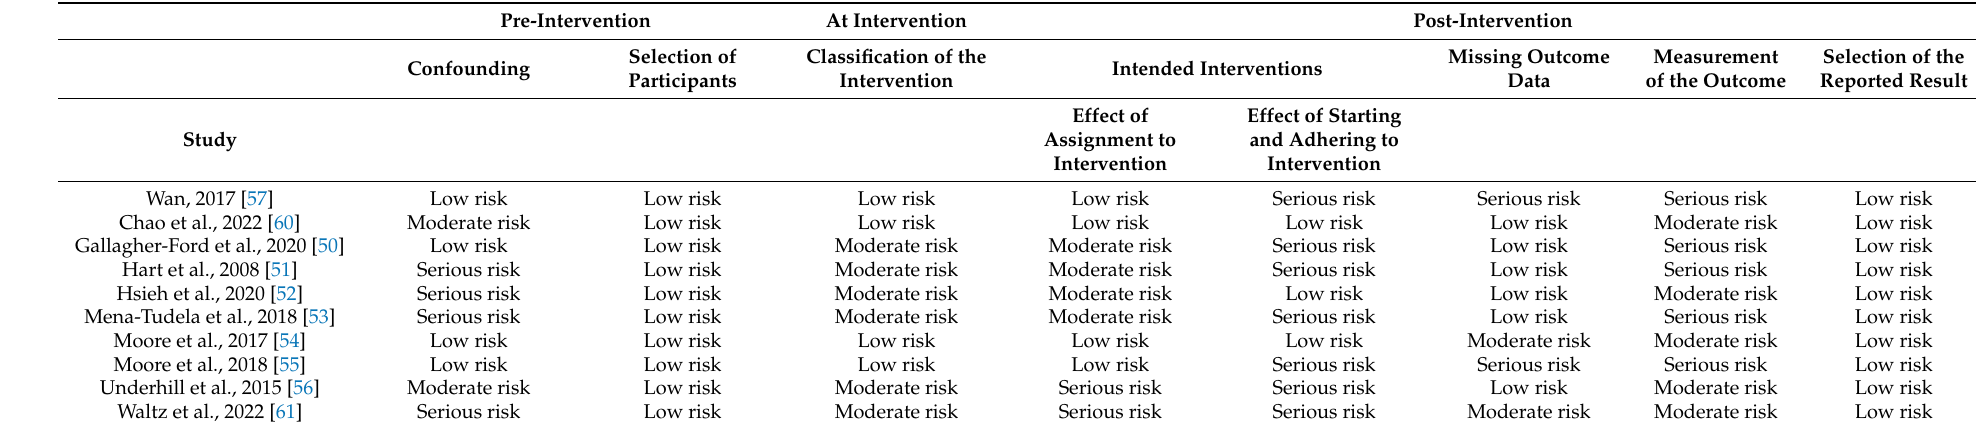
Table 3. ROBINS-I–The Risk Of Bias In Non-randomized Studies of Interventions assessment tool.